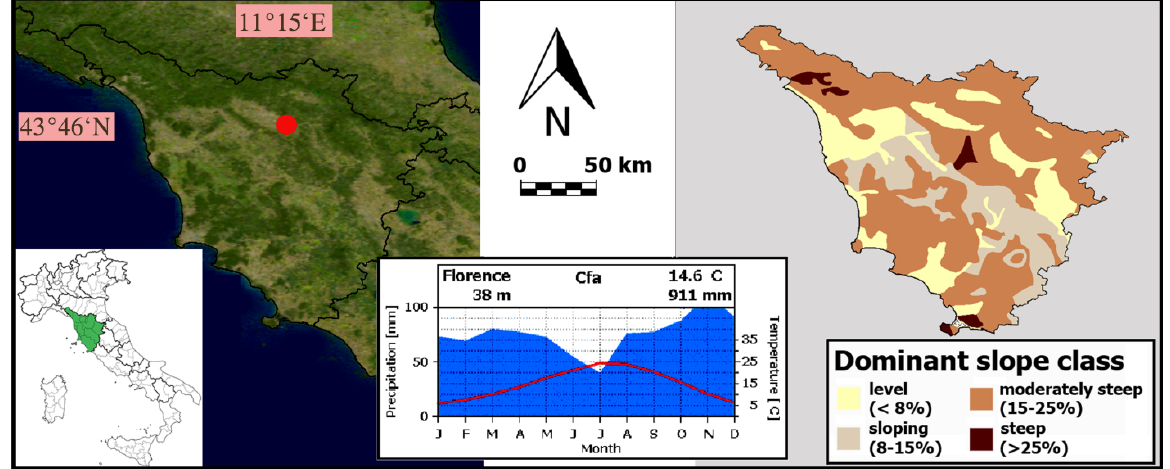
Figure 1. Study area. ( Left ) AVHRR-NDVI image of the study area Tuscany. The location of Tuscany’s capital city, Florence, is indicated with a red dot (coordinates: 43°46 ′ N/ 11°15 ′ E). The small inlet shows the location of Tuscany within Italy. ( Center ) Average climatic conditions for Florence. ( Right ) Generalized dominant slope class map of Tuscany (source: European Soil Database,